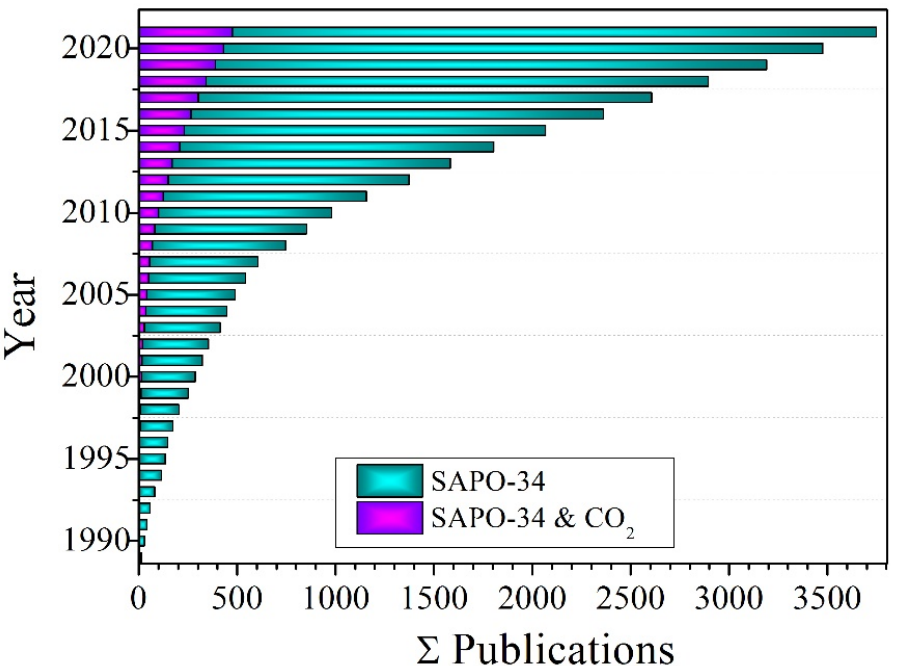
Figure 2. Histograms of SAPO ‐ 34 zeolite literature since 1990. Data were taken from SciFinder using keywords “SAPO ‐ 34” and “SAPO ‐ 34 and CO 2 ”.